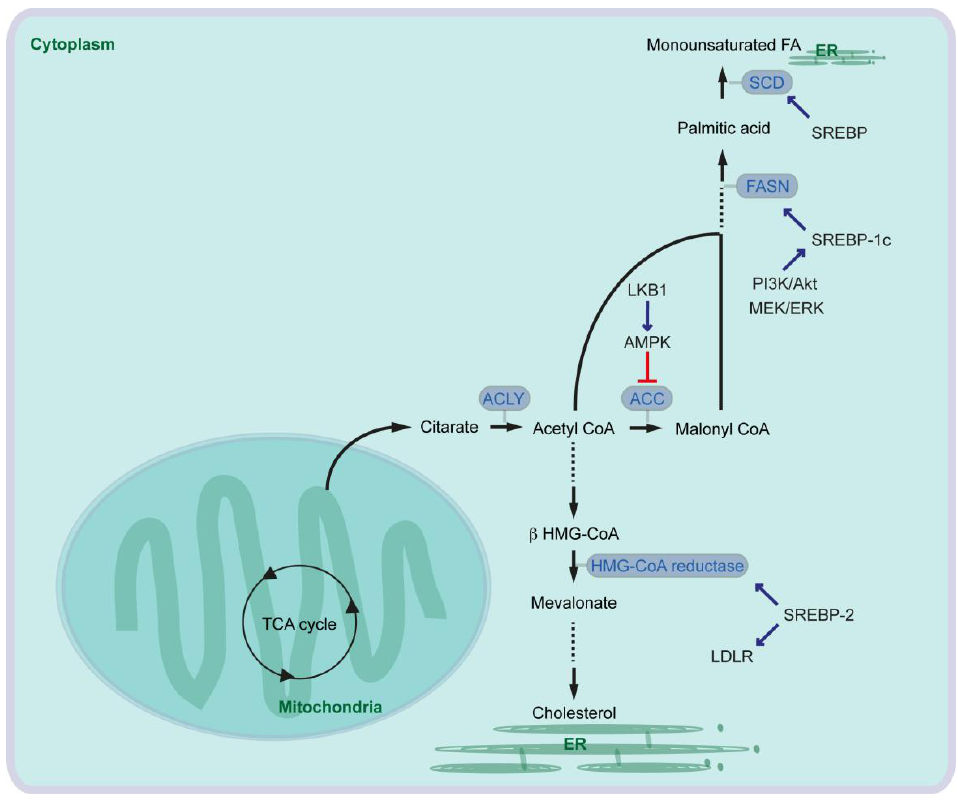
Figure 1. Central pathway for fatty acid and cholesterol synthesis (ACC: Acetyl-CoA carboxylase; ACLY: ATP-citrate lyase; AMPK: AMP-activated protein kinase; ER: endoplasmic reticulum; FA: fatty acid; FASN: fatty acid synthase; HMG: 3-hydroxy-3-methylglutaryl-coenzyme A; LKB1: liver kinase B1; LDLR: low-density lipoprotein receptor; SCD: ∆ 9 -stearoyl-CoA desaturase; SREBP: sterol